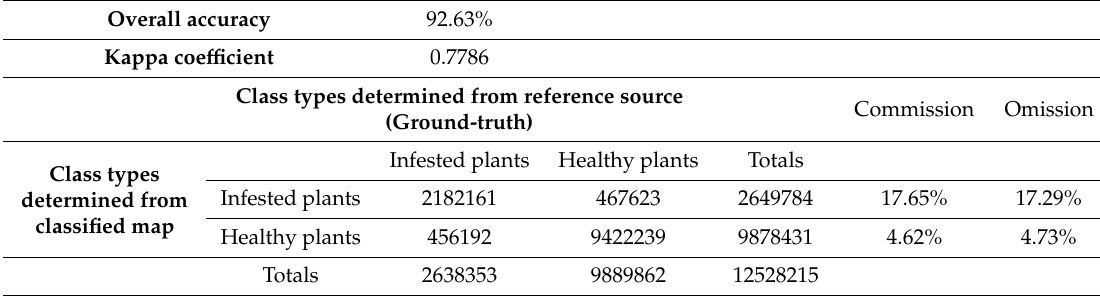
Table 2. Confusion matrix of k-means segmentation regional classification for Chase